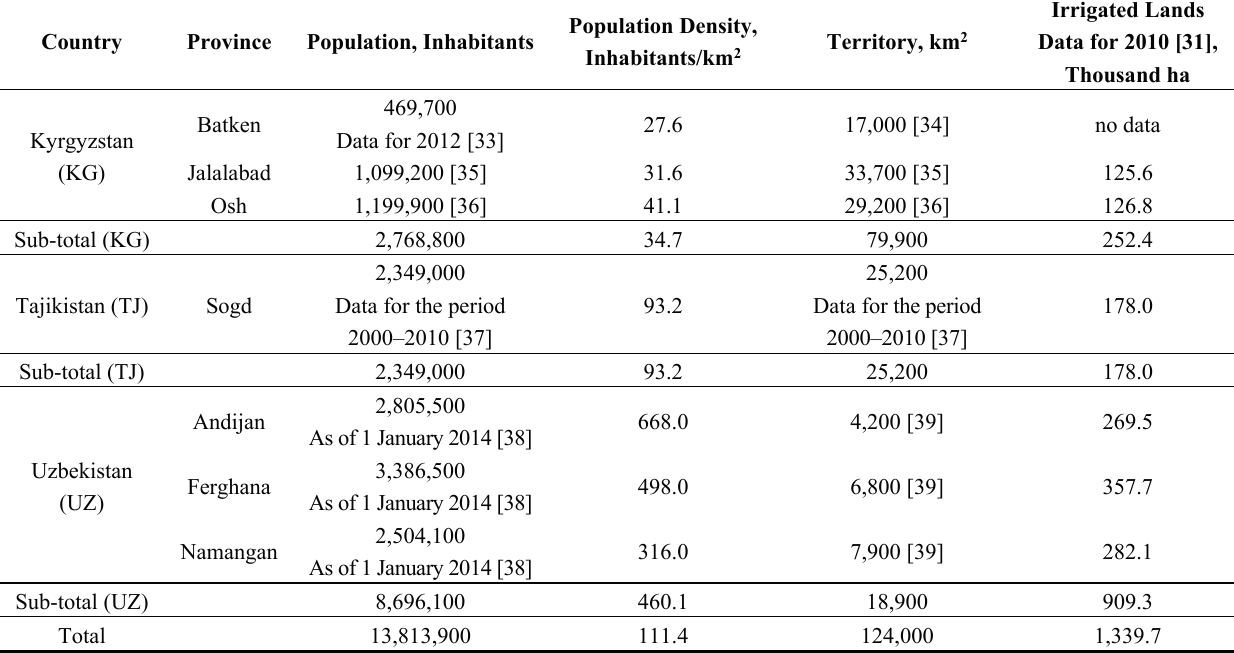
Table 1. Brief information on the Ferghana Valley, upstream of the Syr Darya